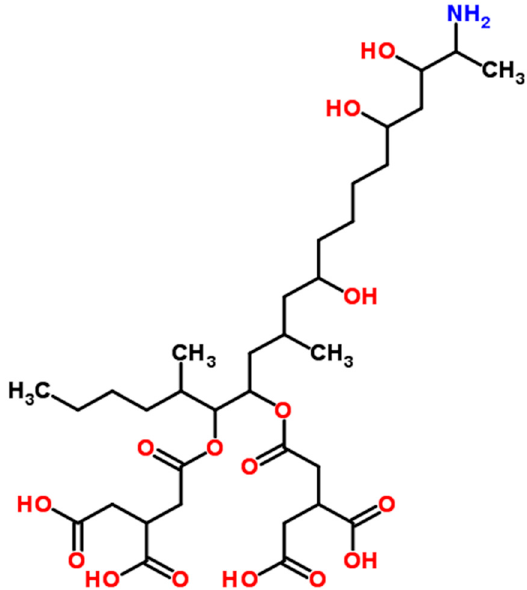
Figure 4. Fuminisin B1 (structure from www.chemspider.com).